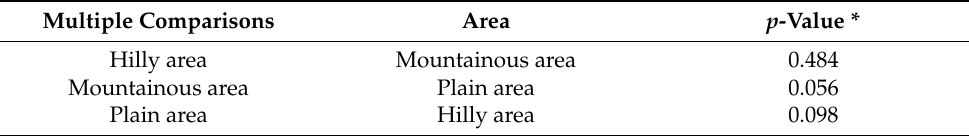
Table 8. Significance of multiple comparisons (by ANOVA) for regulating cultural perceptions in three topographic